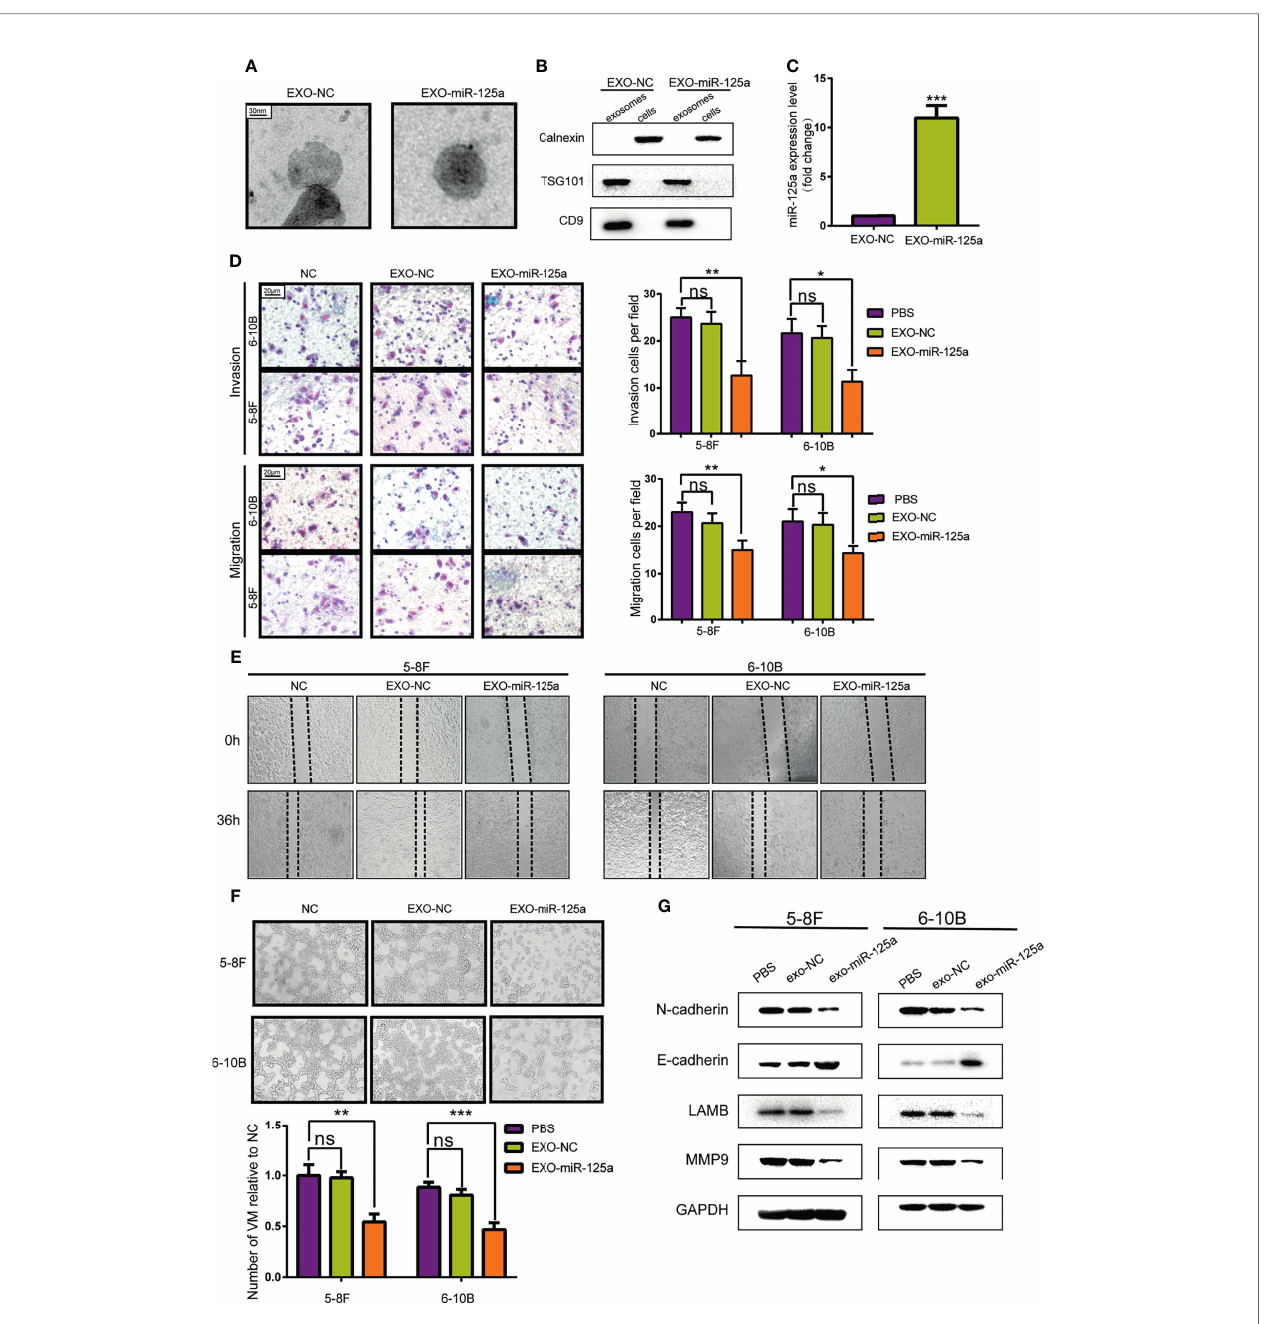
FIGURE 5 | Anti-tumor effect of MSCs-exosomes overexpressing miR-125a in vitro . (A) Electron microscopic photographs of MSC-derived exosomes. (B) Western blot analysis showing the presence for TSG101 and CD9 and the absence of calnexin in exosomes. (C) miR-125a expression in NPCs detected by qRT-PCR after treatment with EXO-NC or EXO-miR-125a. (D) Transwell assay with histogram for cell numbers. (E) Wounding assay detected at 0 and 36 h respectively. (F) VM formation assay with quanti fi ed chart. (G) Western blot assay detecting EMT-related proteins. (ns, not signi fi cant; *P < 0.05; **P < 0.01; ***P <